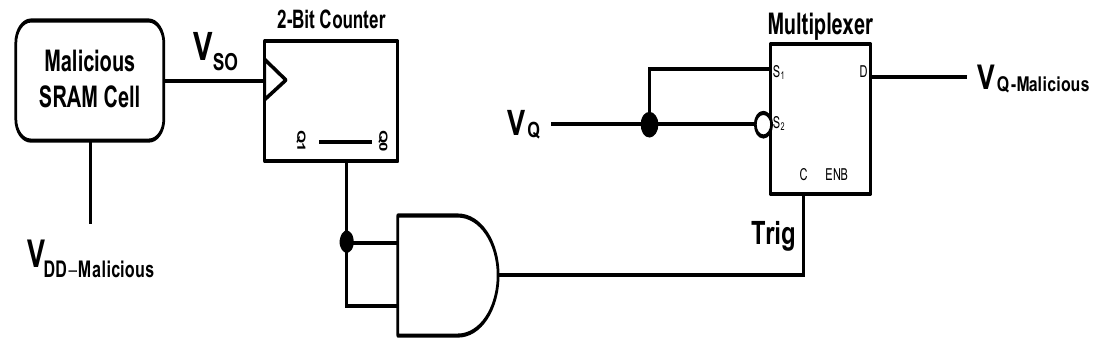
Figure 6. Attack 3: The controllable hardware Trojan circuit for manipulation of the modulator output